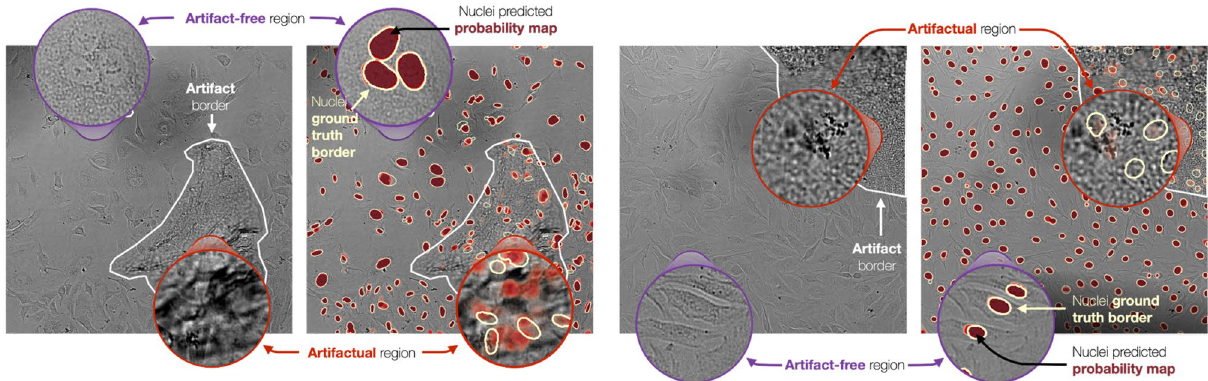
Figure 4. Visual impact of artifacts on nuclei segmentation. Two pairs of brightfield images with corresponding nuclei segmentation (in dark red) overlaid. Zoomed-in purple circles represent examples of artifact-free areas and artifactual areas (light red). White contours: artifact borders; yellow-ish white contours: nucleus ground truth borders; arrows and text: guides to corresponding regions and elements.